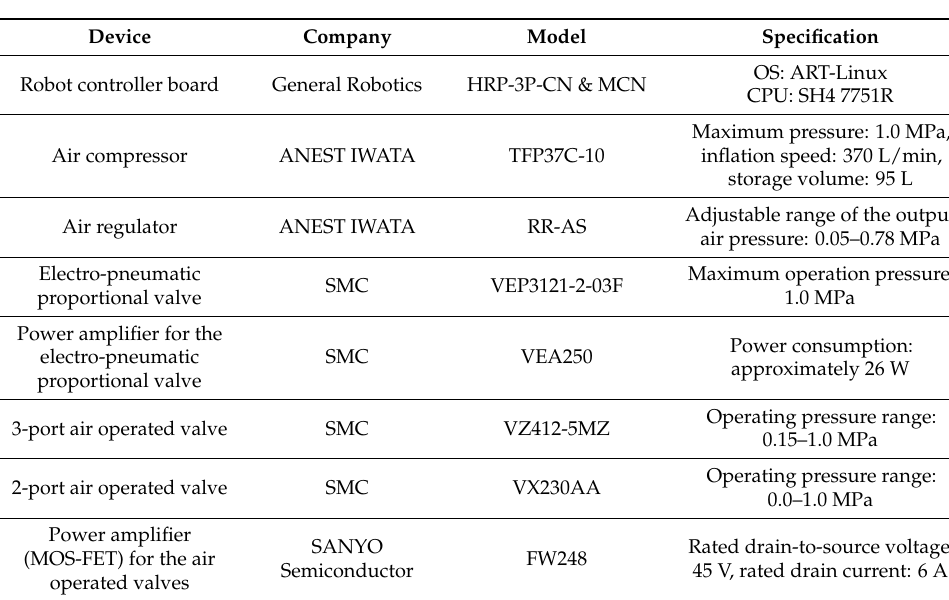
Figure 2. ( a ) Picture of our quadruped, ( b ) overall diagram of our system. Table 1. List of external devices in Figure